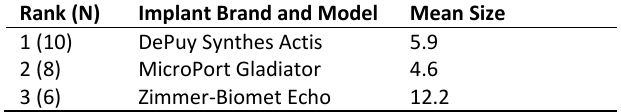
Table IIc. The three most commonly implanted metallic femoral stem